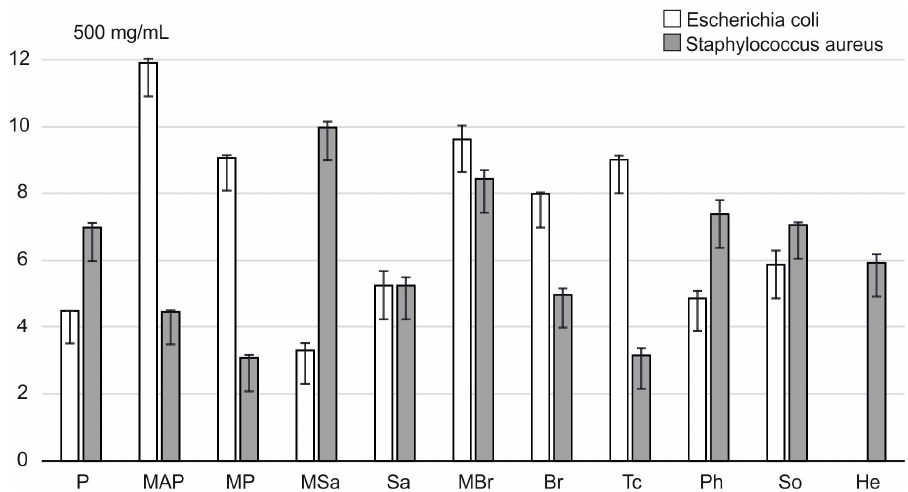
Figure 4. Inhibitory activity of tested honey types relative to E. coli and S. aureus. Figure 4. Mean inhibitory activity of tested honey types relative to E. coli and S. aureus